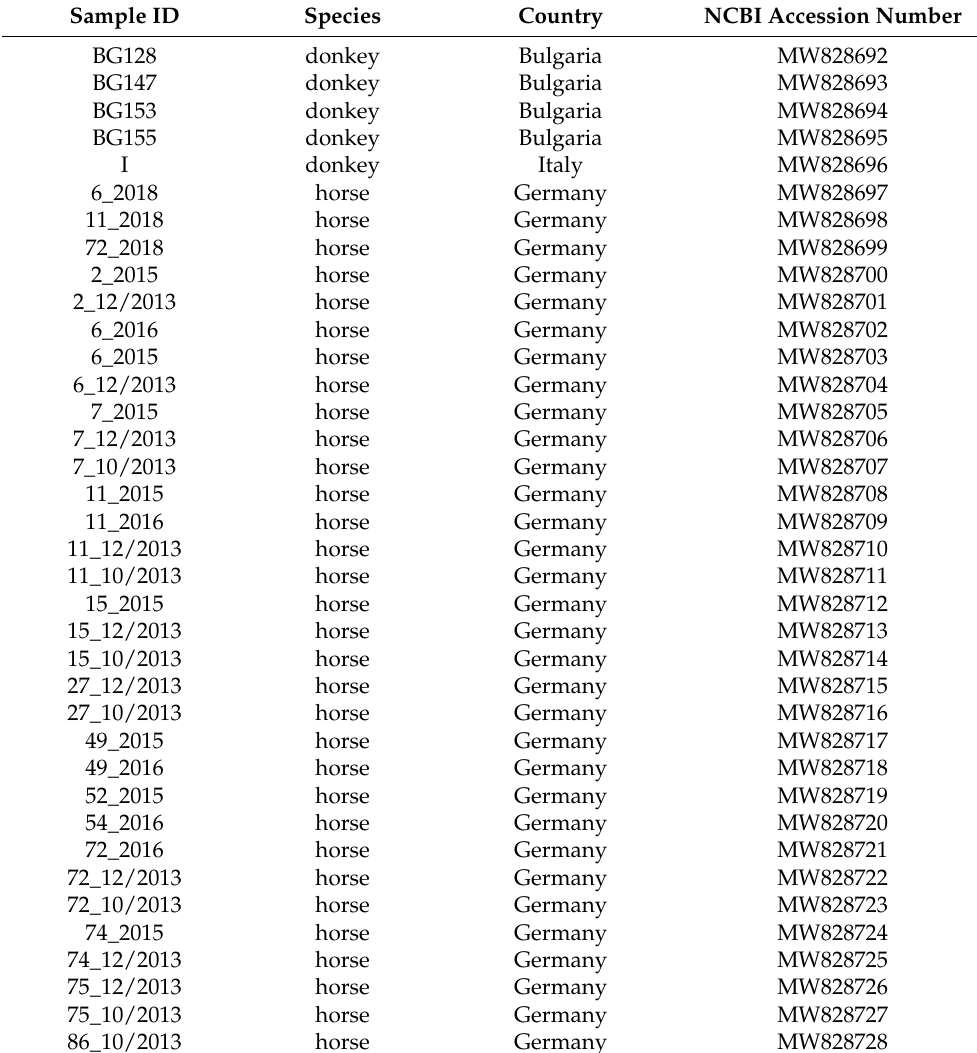
Table 3. Sequences from this study were submitted to the NCBI database. Each sample was assigned to the following accession numbers and sample ID refers to Figure